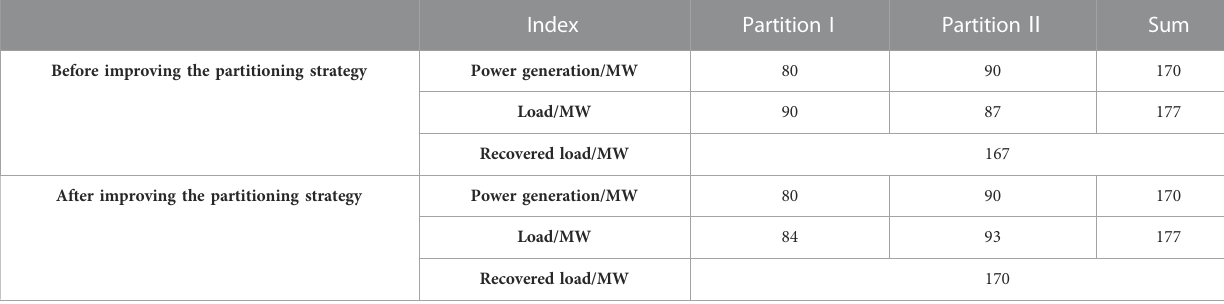
TABLE 8 Generation and load values for each partition.